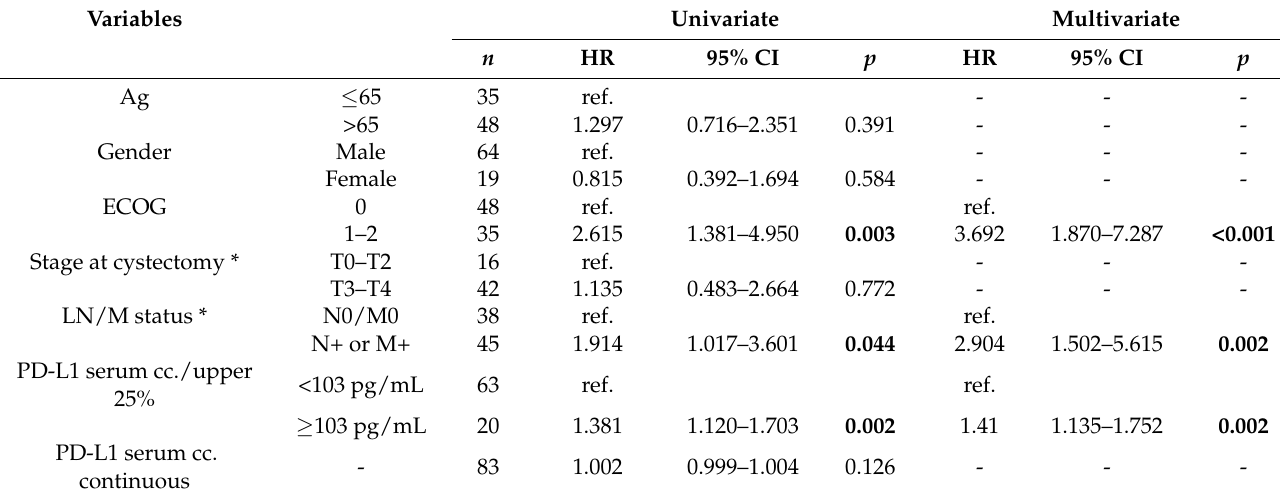
Table 3. Cox uni- and multivariate OS analysis in platinum-treated